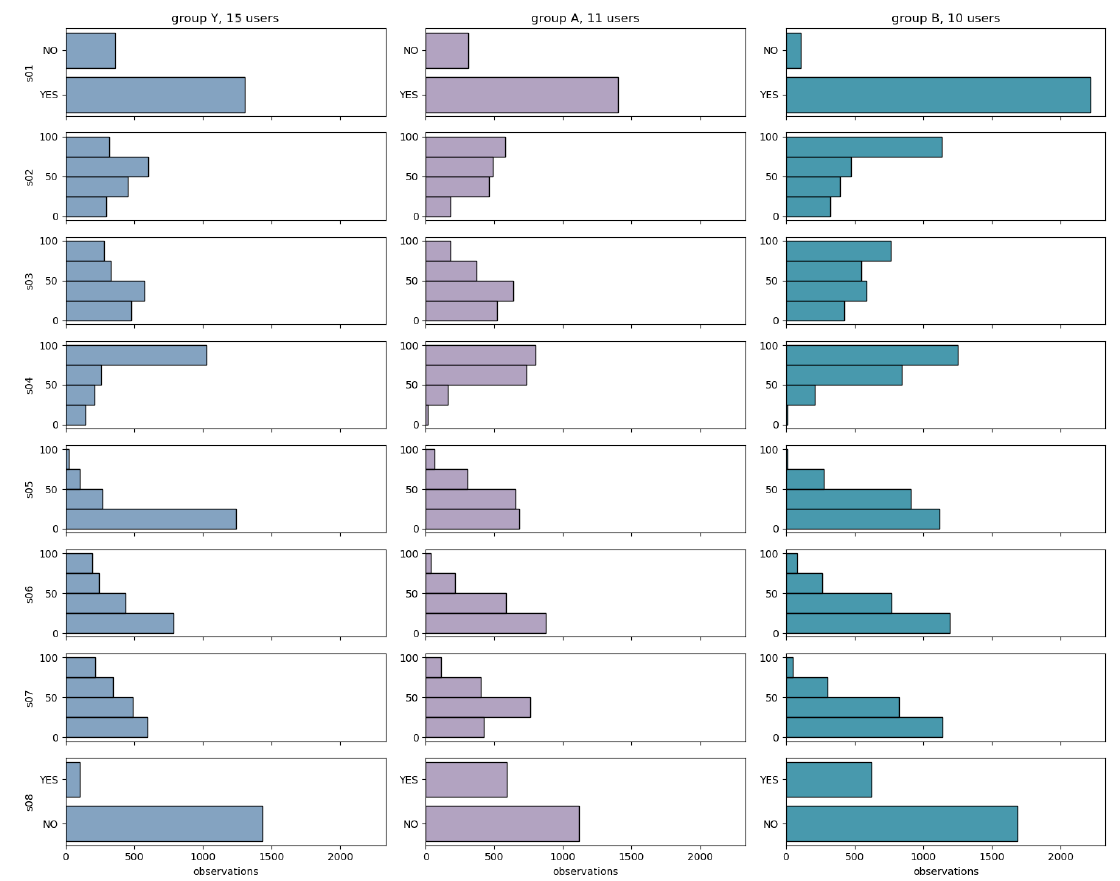
Figure 3. Data distribution of the answers to each questionnaire item across the groups Y, A and B.